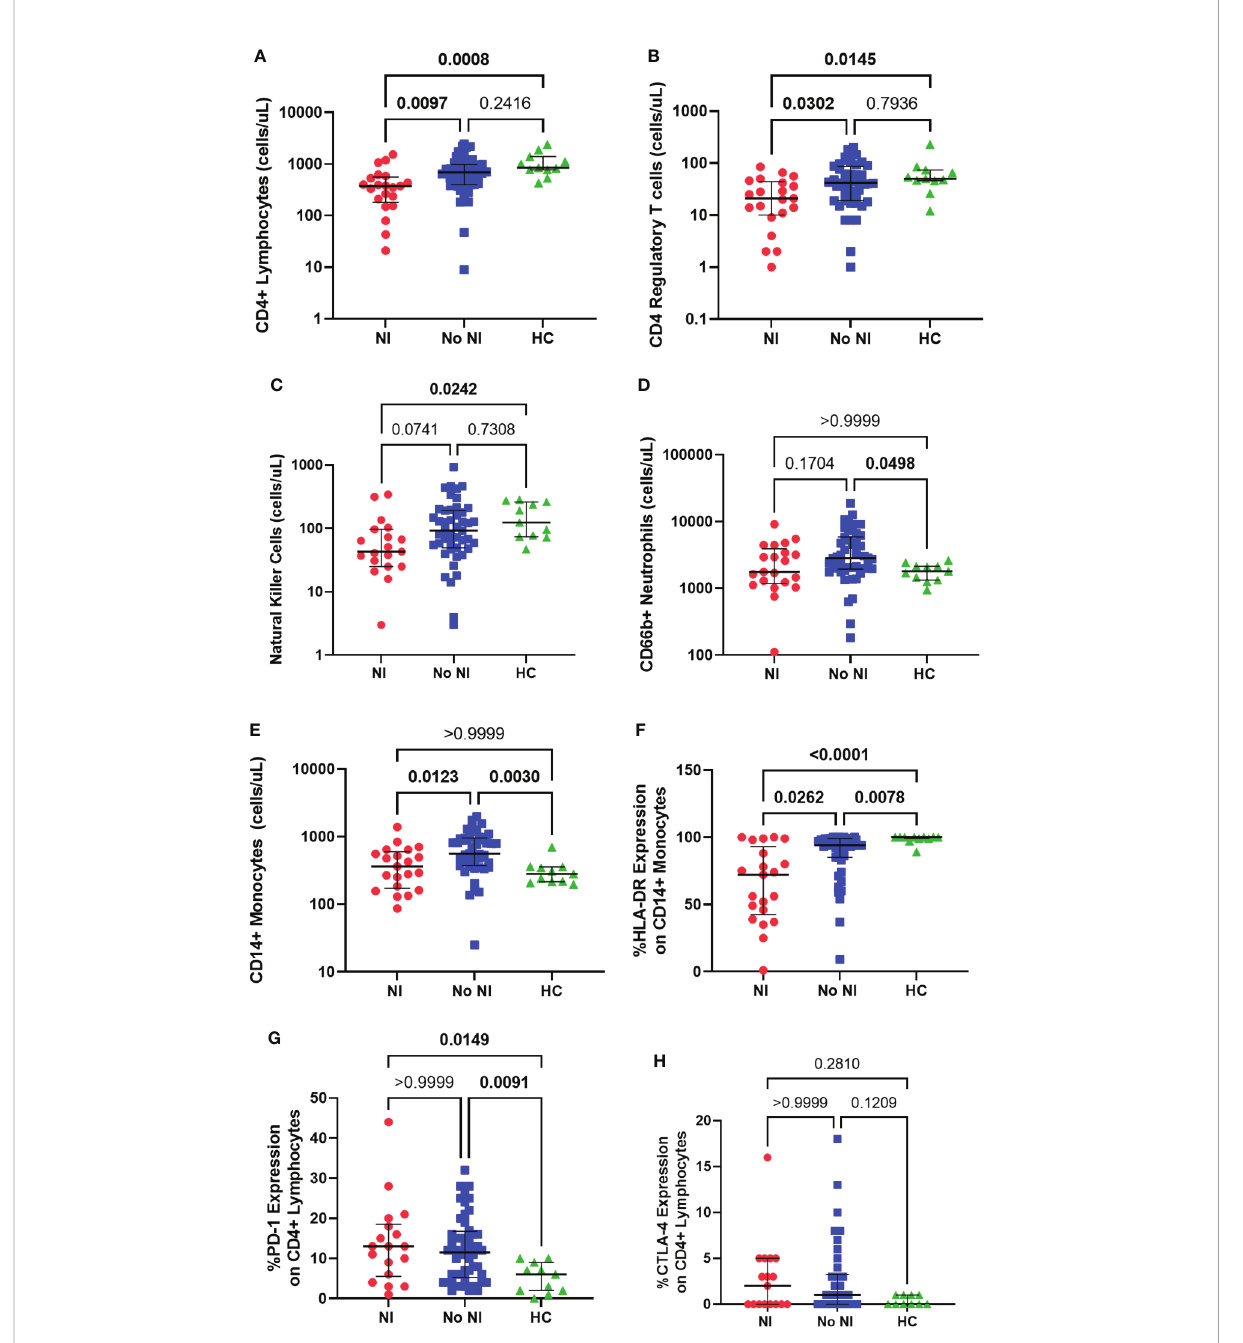
FIGURE 2 Immune cell presence within the fi rst 72 hours following pediatric thermal injury. Adaptive immune cells as measured through absolute CD4+ lymphocytes (A) , CD4 regulatory T cells (B) and natural killer cells (C) were decreased in subjects who went on to develop an infection (n=21, 21, 19, respectively) relative to those who did not (n=48, 47, 46, respectively) and healthy controls (n=11). Innate immune cells as measured through CD66b+ neutrophils (D) and CD14+ monocytes (E) were elevated in children who recovered without developing an infection (n=46, 47, respectively) relative to healthy controls (n=11) and those who did develop an infection (n=21). CD14+ monocyte HLA-DR expression (F) was signi fi cantly lower in children that went on to develop NI (n=21) compared to those patients that did not (n=46) and healthy controls (n=11). Burn injury regardless of infection (NI, n=18 and No NI, n=48) signi fi cantly decreased median percent PD-1 expression on CD4+ lymphocytes (G) relative to healthy controls (n=11) but displayed no difference between burn groups. There was no signi fi cant difference in the percent CTLA-4 expression (H) between groups (NI, n=17, No NI, n=42, HC, n=10). Statistical analysis was performed using one-way ANOVA plus Dunn ’ s test. Lines represent median and interquartile range; dots represent the individual data points. NI, nosocomial infection (red); No NI, no infection (blue); HC, healthy control